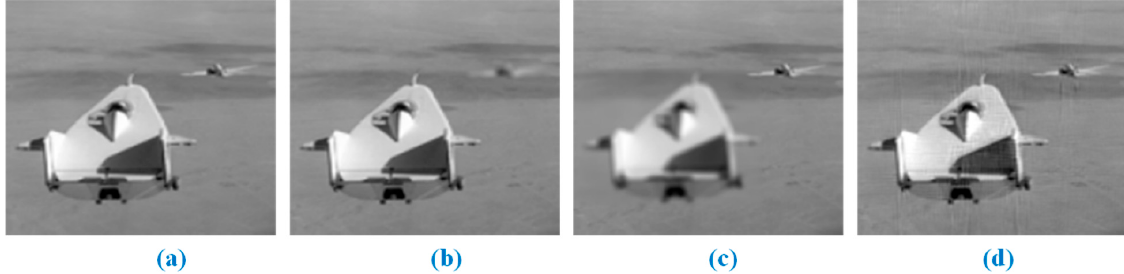
Figure 8. (Craft): ( a ) original image; ( b , c ) multi-focus input images; and ( d ) proposed fusion.